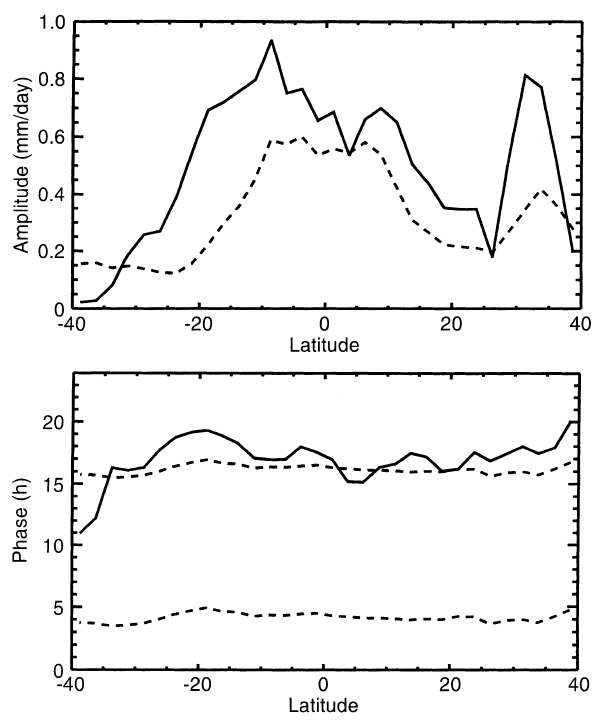
Fig. 4. Amplitudes ( top ) and phases ( bottom ) of the diurnal ( solid line ) and semidiurnal ( dashed line ) variations in rainfall, as a function of latitude. These curves correspond to the 7-year annual- and longitude- mean rainfall-rate distribution, derived from Fourier decomposition (in local time) of the data presented in the bottom panel of Fig. 3. (Longitude mean in this context implies that part of the rainfall-rate distribution that migrates with the apparent motion of the sun.) These rainfall rates serve as the normalization factor A in Eq. 2 for the diurnal and semidiurnal latent heating rates